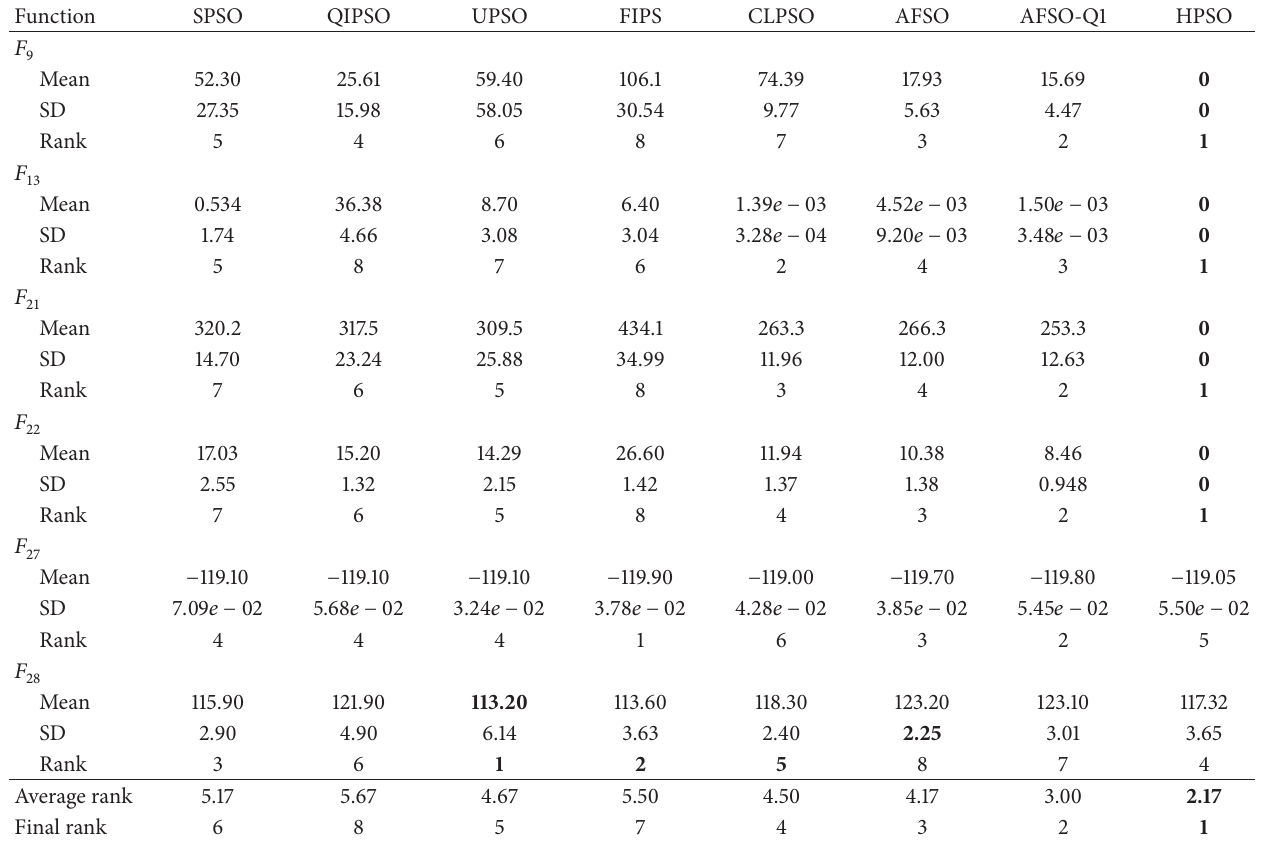
Table 7: Comparison results of seven PSO algorithms [25] with HPSO on six functions ( 𝑁 = 30 , 𝐷 = 30 , and 𝑇 = 10,000).